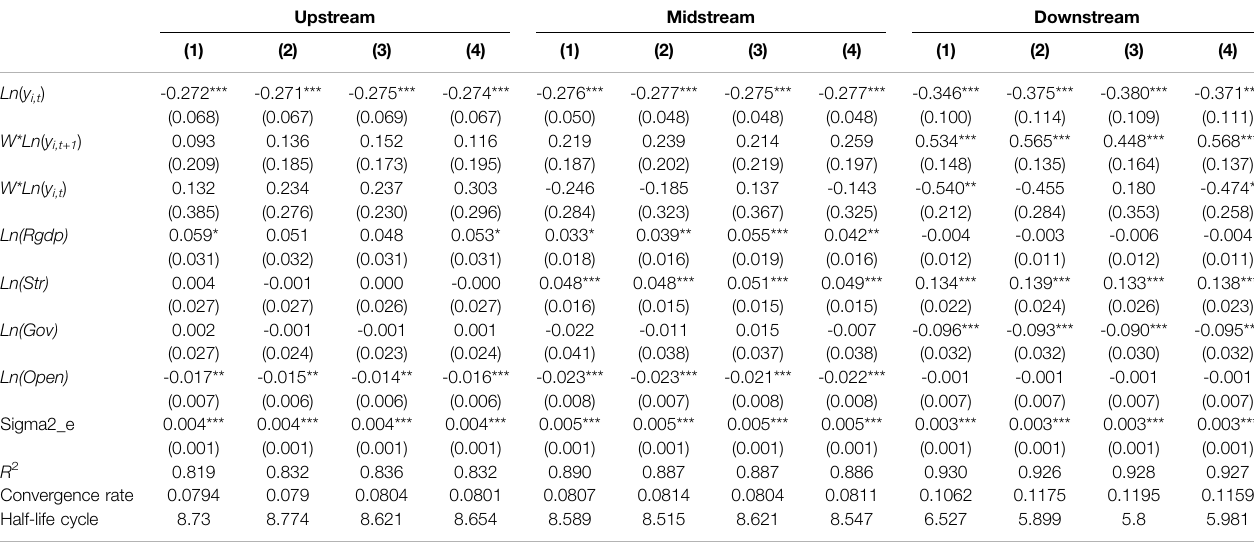
TABLE 4 | Club convergence results of the green economic ef fi ciency in the YREB. Upstream Midstream